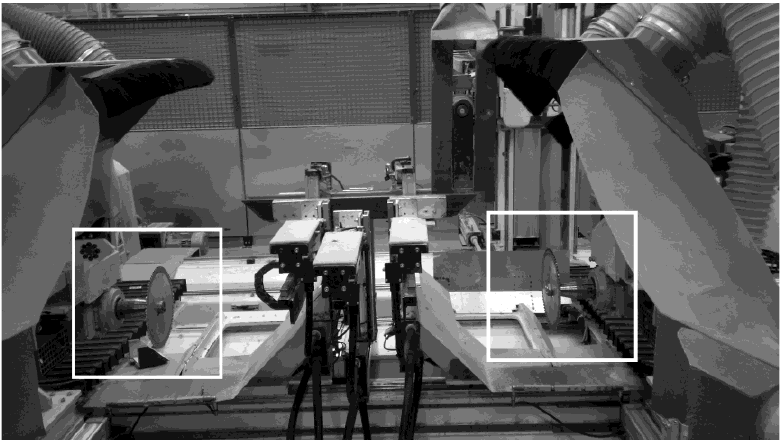
Figure 4. The pair (non-treated and ion-implanted) circular saw blades during simultaneous work.